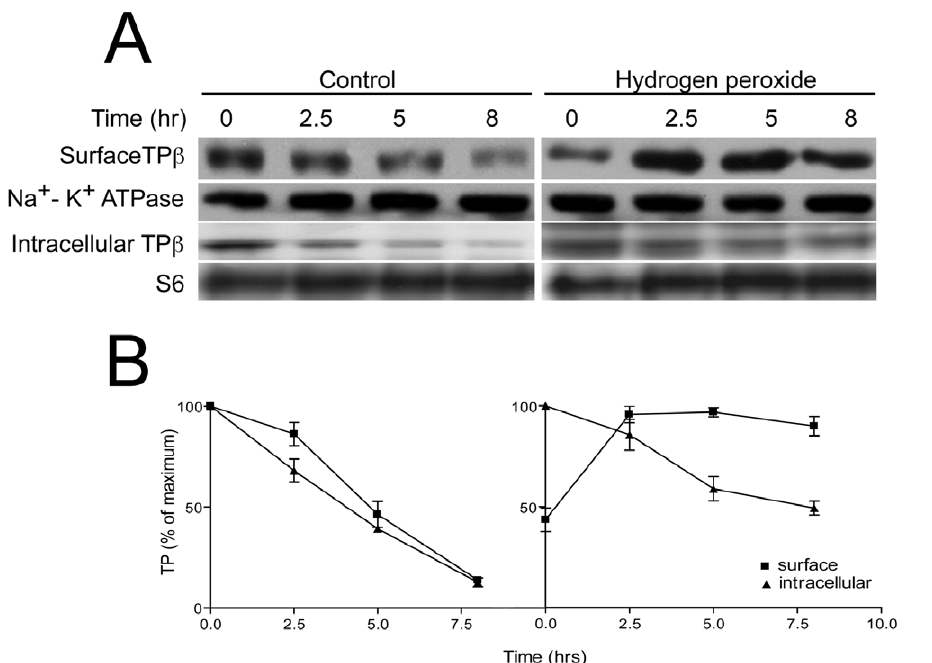
Figure 4. Kinetic analysis of intracellular and cell-surface HA-TP b levels following hydrogen peroxide exposure. Cycloheximide (30 m M) was added to HEK293 cells stably expressing HA-TP b and kinetic studies performed in the absence and presence (Panel A) of hydrogen peroxide (10 m M). At times 0, 2.5, 5 and 8 hours following addition of cycloheximide and hydrogen peroxide the cultures were placed on ice and cell- surface proteins labelled with a water-soluble biotin analogue. Labelled cell-surface HA-TP b was recovered by incubating with streptavidin beads and the remaining intracellular fraction precipitated using trichloroacetic acid. Both fractions were analyzed using anti-HA murine monoclonal and HRP- conjugated secondary antibodies. Equal loading was confirmed by reprobing membranes with anti-Na + -K + ATPase antibody (surface) and anti- ribosomal S6 antibodies (total lysate). Re-probing the membrane fraction with S6 antibodies indicated the absence of any contamination by intracellular proteins, i.e. from cell lysis (data not shown). Panel B represents the quantified data expressed as percentage change of intracellular and cell-surface HA-TP b expression in the absence and presence of hydrogen peroxide, with data normalized to t=0. In the absence of hydrogen peroxide, both cell-surface and intracellular HA-TP b decline over 8 hours, but the hydrogen peroxide treated cultures demonstrate sustained HA-TP b levels. The data are representative of the means 6 SE of three independent experiments.